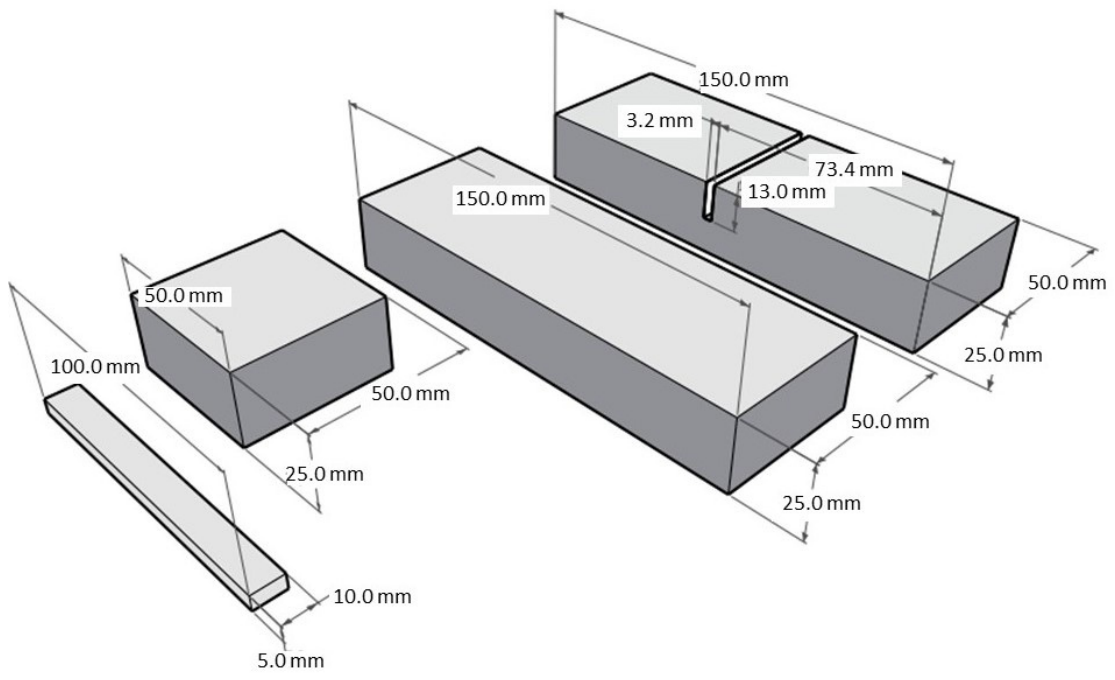
Figure 1. Test specimens subjected to 24 h water uptake and release tests (100 (ax.) × 10 × 5 mm 3 ), floating test (50 (ax.) × 50 × 25 mm 3 ) and submersion test (150 (ax.) × 50 × 25 mm 3 ) without and with a notch (depth: 13.0 mm, width: 3.2 mm); sides of floating and submersion test specimens were sealed (dark gray) with polyurethane (Sikaflex ® 221i, Sika Austria GmbH, Austria). Table 1. Moisture content of 100 (ax.) × 10 × 5 mm 3 specimens after exposure to different moistening and drying regimes during 24 h intervals.